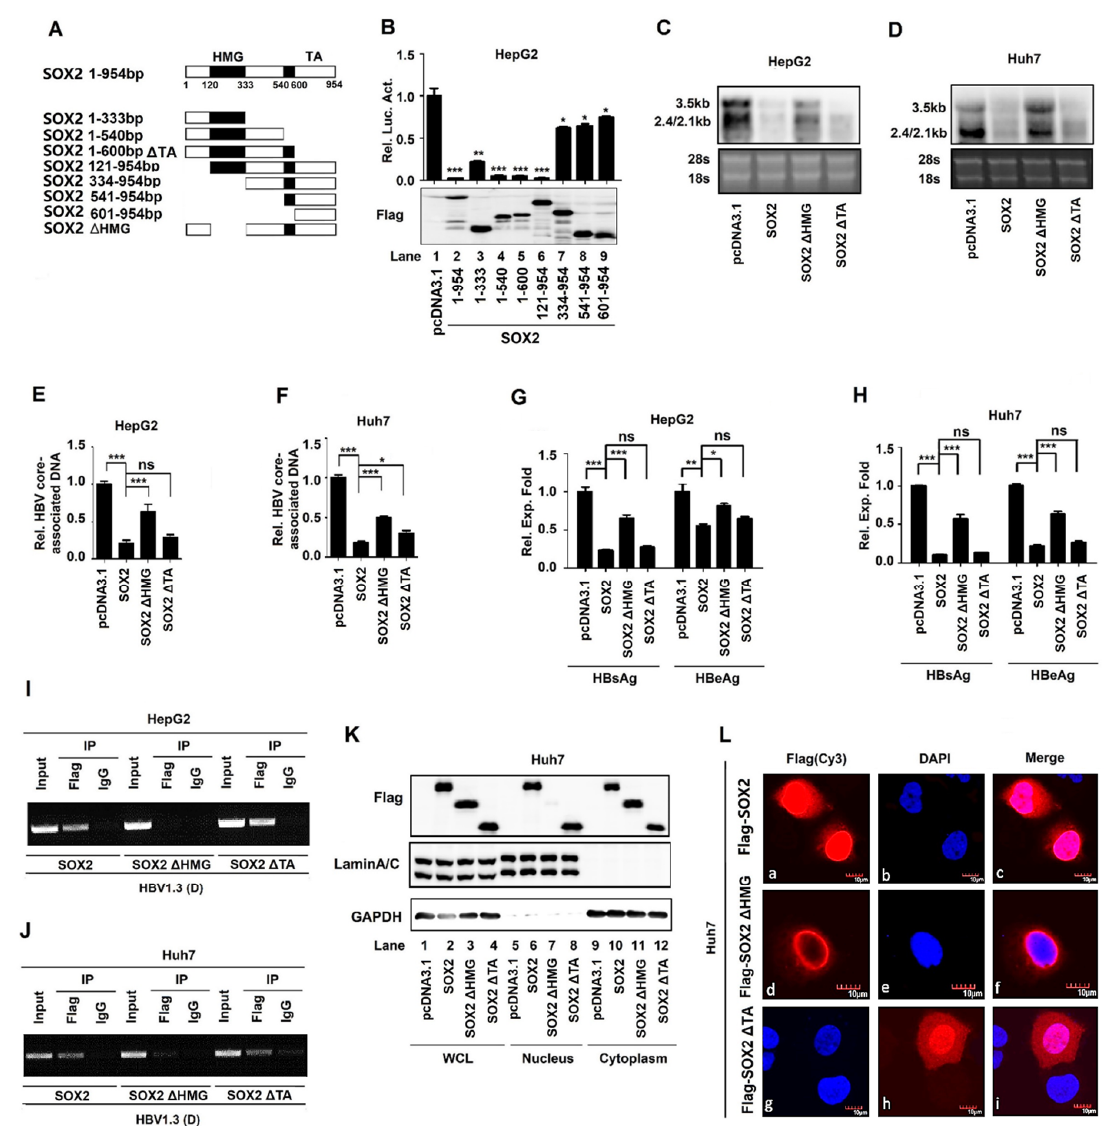
Figure 4. The HMG domain is required for SOX2-mediated repression of HBV replication. ( A ) Schematic diagrams of SOX2 functional domains and serial truncated mutants. ( B ) HepG2 cells were plated in 24-well plates and co-transfected with pGL-3-EnhII / Cp-Luc and pcDNA3.1, pcDNA3.1-SOX2, orpcDNA3.1-SOX2(1–333nt), pcDNA3.1-SOX2(1–540nt), pcDNA3.1-SOX2(1–600nt), pcDNA3.1-SOX2 (121–954 nt), pcDNA3.1-SOX2 (334–954 nt), pcDNA3.1-SOX2 (541–954 nt), or pcDNA3.1-SOX2 (601–954 nt), respectively, for 48 h. The activities of luciferase were measured and normalized to control (upper). The productions of SOX2 and its mutants were confirmed by Western blot (lower). ( C , D ) HepG2 cells (C) and Huh7 cells (D) were plated in 6-well plates and co-transfected with pBlue-HBV1.3 and pcDNA3.1, pcDNA3.1-SOX2, pcDNA3.1-SOX2 ∆ HMG, or pcDNA3.1-SOX2 ∆ TA, respectively, for 48 h. Total RNA was extracted and HBV 3.5 kb and 2.4 / 2.1 kb RNA were measured by Northern blot. The 28s and 18s rRNAs were used as the internal controls. ( E – H ) HepG2 cells (E and G) and Huh7 cells (F and H) were plated in 12-well plates and then co-transfected with pBlue-HBV1.3(D) and pcDNA3.1-SOX2, pcDNA3.1-SOX2 ∆ HMG, or pcDNA3.1-SOX2 ∆ TA, respectively, for 48 h. HBV core-associated DNA was extracted and detected by qRT-PCR (E and F). HBsAg and HBeAg in cell culture supernatants were analyzed by ELISA (G and H). ( I , J ) HepG2 and Huh7 cells were plated in 6 cm dishes and co-transfected with 3 µ g pBlue-HBV1.3 and 3 µ g pcDNA3.1,